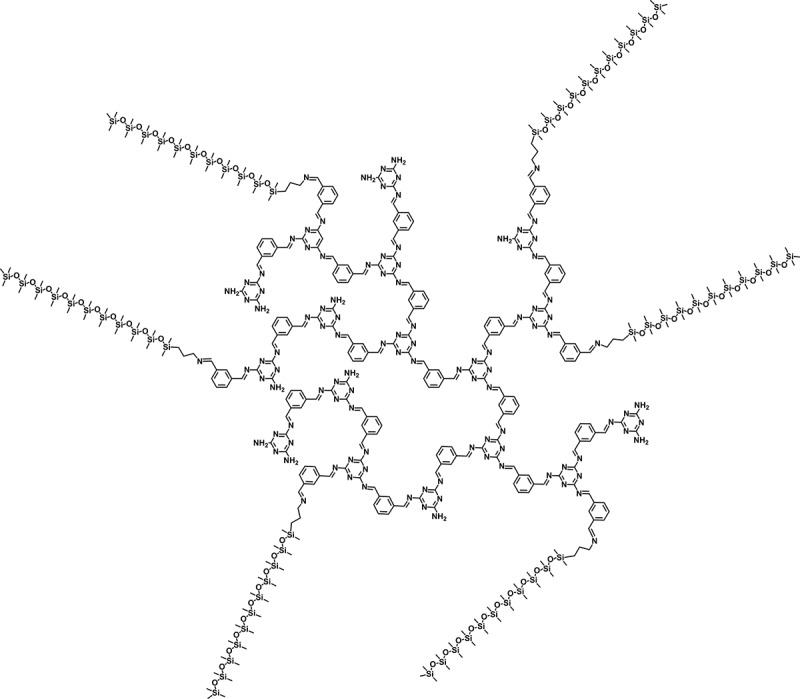
An example of the structure of HBP-PAZ-SiO9 (DP = 15).